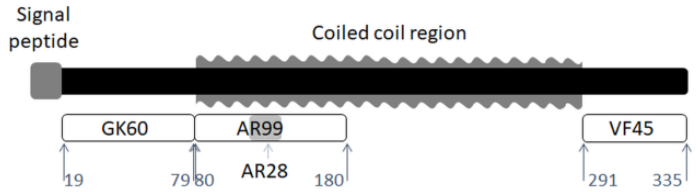
Figure 1. Schematic representation of the locations of the peptides used in this study within the honeybee silk protein AmelF3.